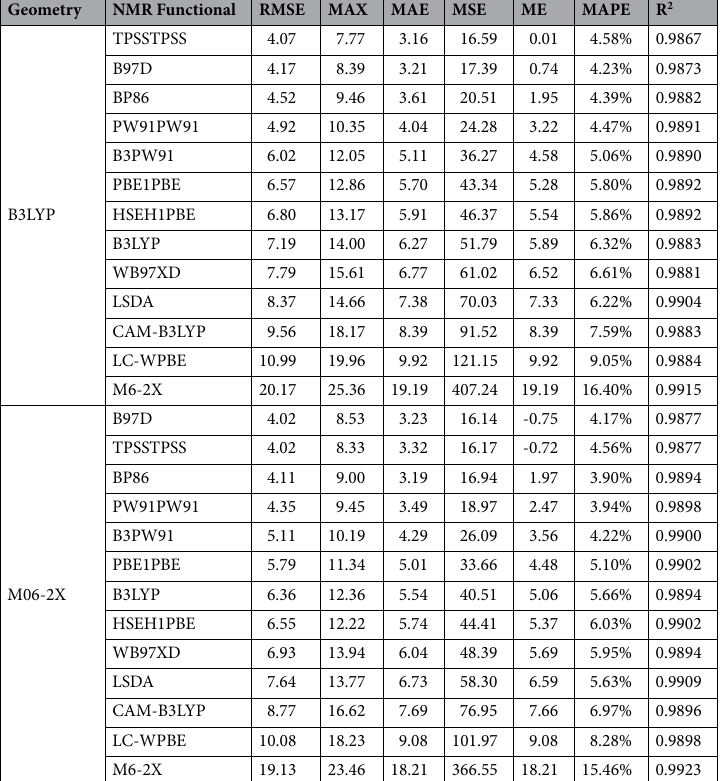
Table 2. Averaged statistical descriptors RMSE, MAX, MAE, MSE, ME MAPE, and determination coefficient (R 2 ) computed for 13 C NMR deviations obtained for each geometry and functional combination. The table is sorted by RMSE